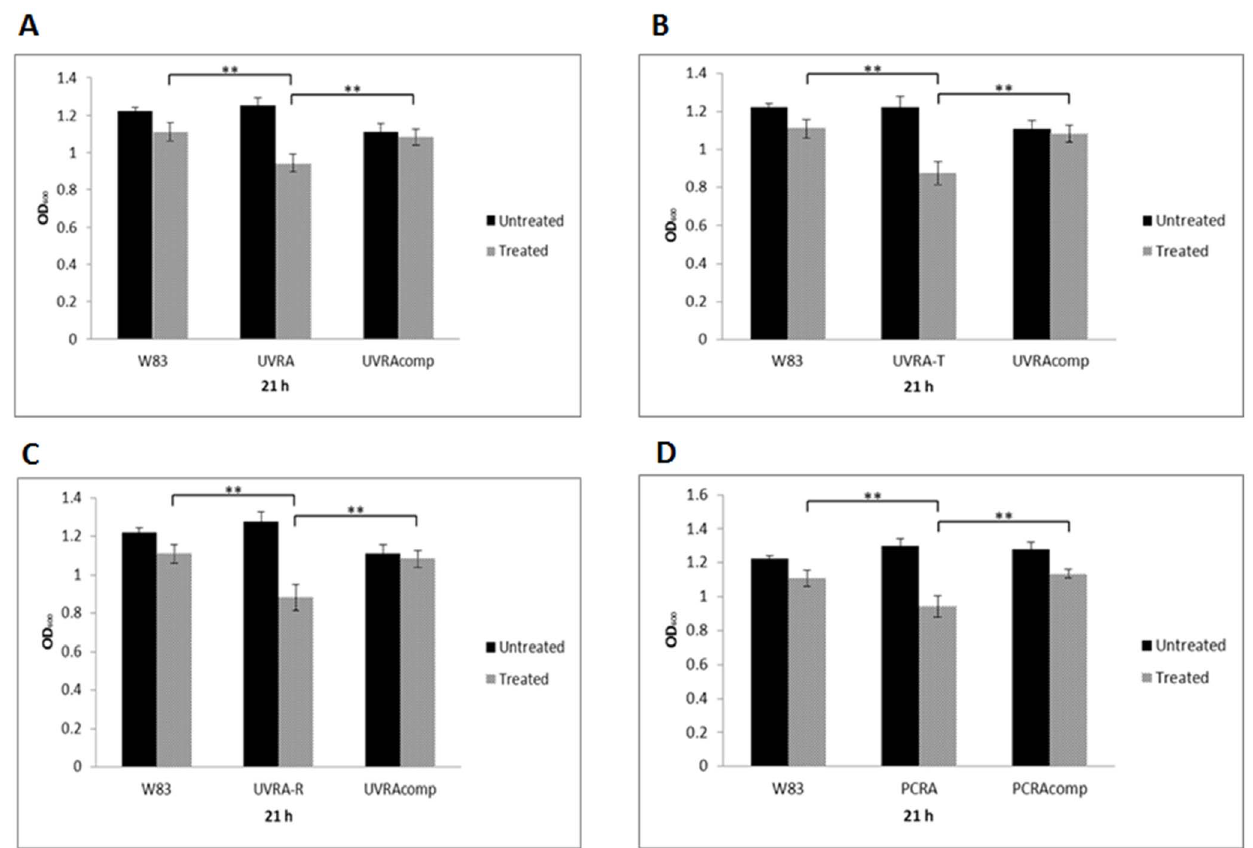
Figure 4. Sensitivity of P.gingivalis mutants to hydrogen peroxide. P. gingivalis was grown to early log phase (OD 600 of 0.2) in BHI broth. 0.25 mM H 2 O 2 was then added to the cell cultures and further incubated over 30 h. Cell cultures without H 2 O 2 were used as controls. The greatest observable difference in growth rate and response to H 2 O 2 was seen at 21 h (exponential phase of the growth curve). The results shown are representative of 3 independent experiments each in triplicate. Error bars represent standard error of the mean. **P # 0.01. Asterisks without brackets represent comparisons to treated controls.